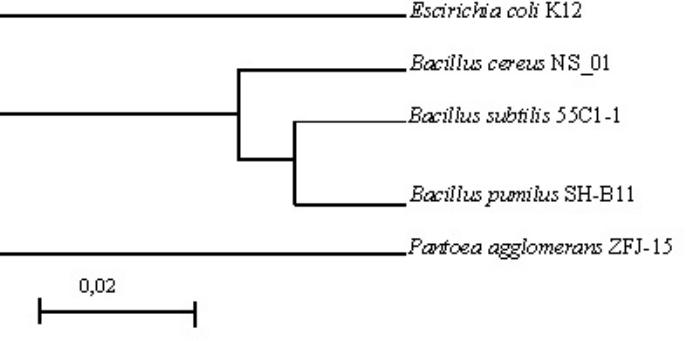
Fig. 2. Phylogenetic tree of 16S rRNA sequence of isolated antibiotic-producing endophytic bacterial in this